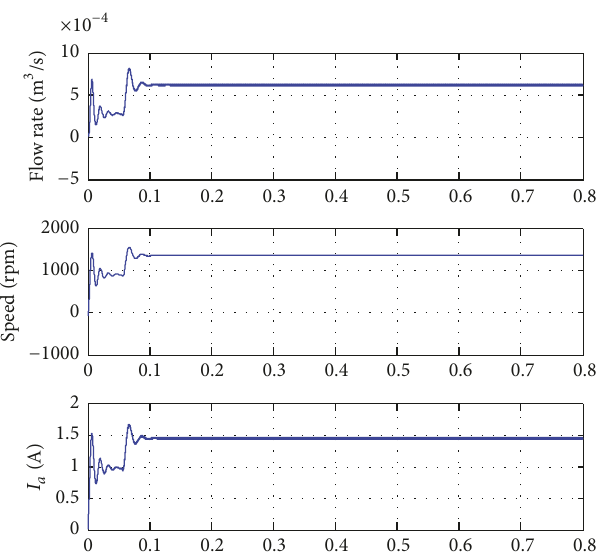
Figure 22: Flow rate, PMDC motor rotor speed, and armature current at various solar irradiation values.